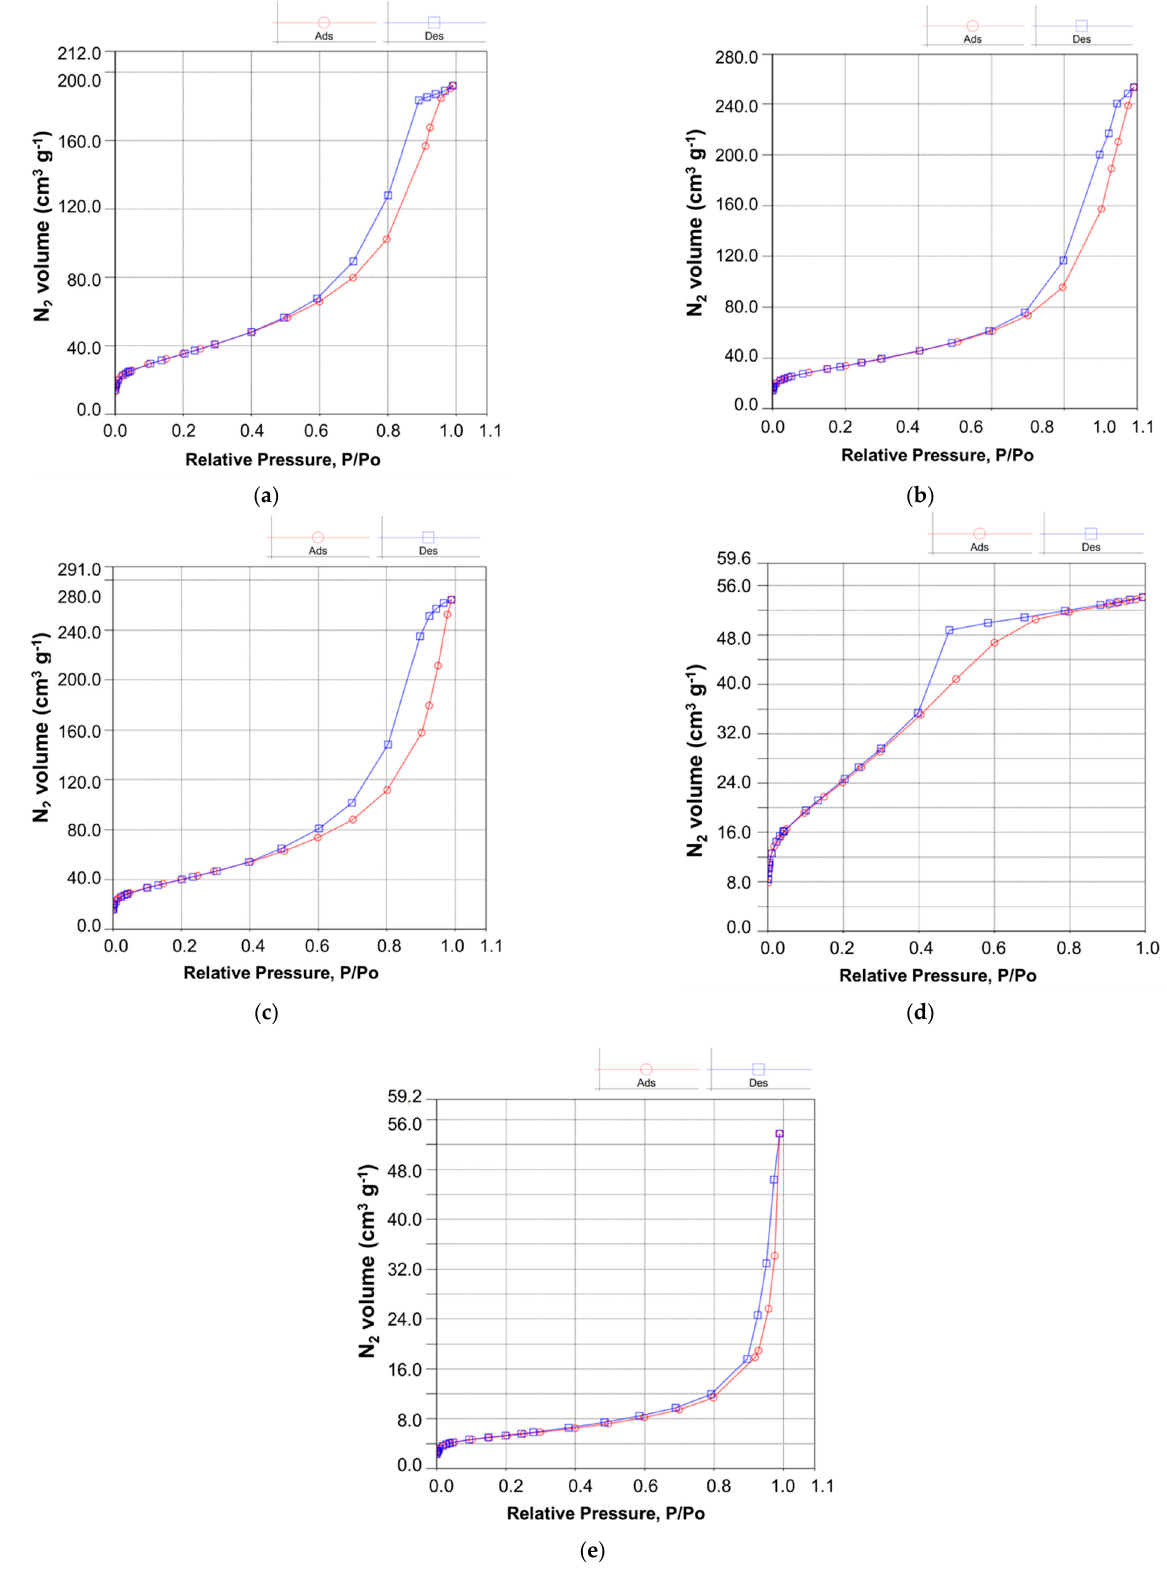
Figure 4. Isotherms of low-temperature (77 K) nitrogen adsorption/desorption of samples: ( a ) Fe 3 O 4 , ( b ) γ -Fe 2 O 3 , ( c ) δ -FeOOH, ( d ) 5Fe 2 O 3 ·9H 2 O, ( e ) α -FeOOH-Fe 2+ .